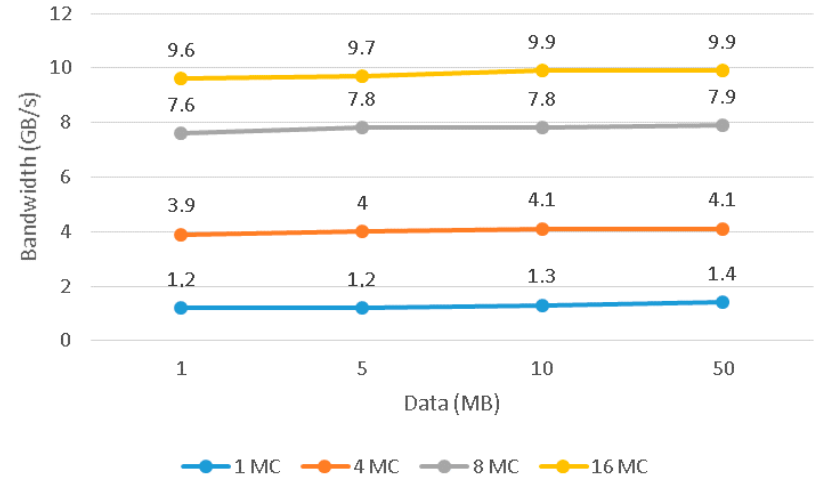
Figure 7. Bandwidth measurement. Different number of MC ports is used for different datasets.